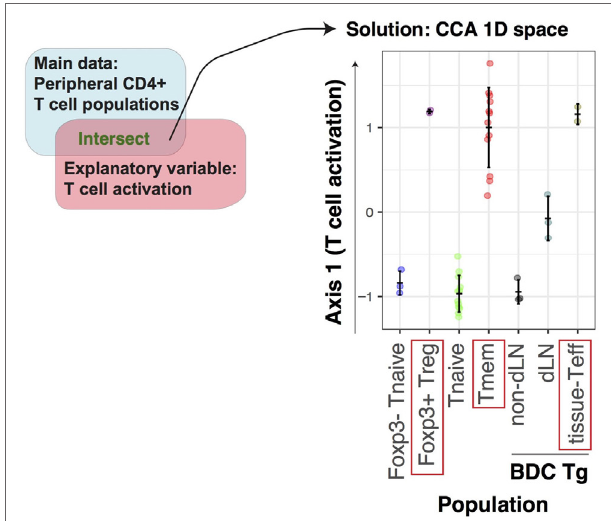
FigUre 2 | Identification of the activation signature in Treg and Tmem by canonical correspondence analysis (CCA) of T cell populations. The microarray dataset of peripheral CD4 + T cells, including naïve, effector, and memory phenotype from various sites (GSE15907), was analyzed using the T cell activation variable, which was obtained from the microarray dataset of conventional activated CD4 + T cells (GSE42276). CCA was applied to the T cell population data using an explanatory variable for T cell activation, which was obtained as fold change between activated and resting conventional CD4 + T cells. The CCA solution is thus 1D, and is used as “T cell activation score” (see Materials and